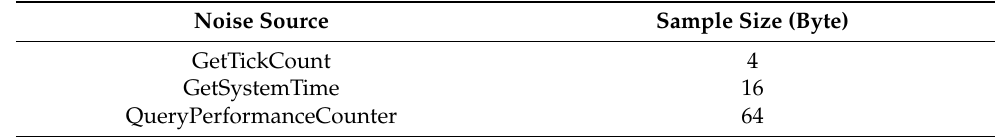
Table 1. Noise source associated with the CPU of the Microsoft Windows operating